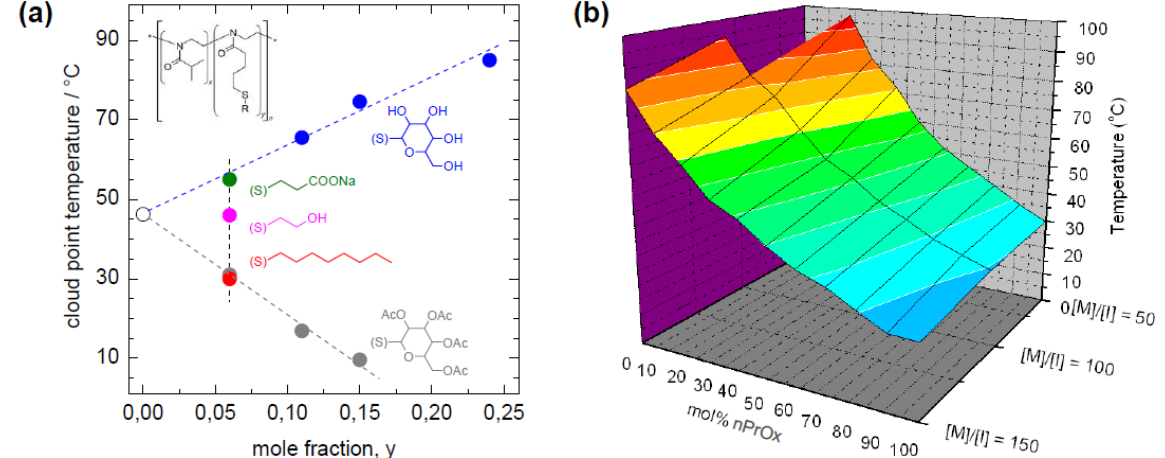
Figure 1. ( a ) Effect of the nature of side-chains on the cloud point temperature of PiPrOx-based statistical copolymers at 0.1 wt% in physiological saline solution [28], reproduced by permission of Wiley-VCH. ( b ) Cloud points of statistical PEtOx-PnPrOx copolymers as a function of composition and molecular weight, measured at 0.5 wt% in water [29], reproduced by permission of the Royal Society of